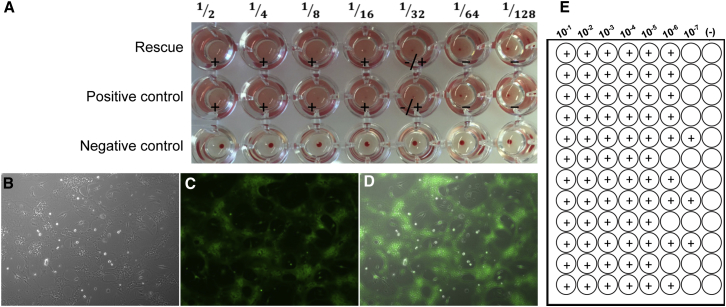
Typical Hemagglutination Assay Results Showing Successful Rescue of rNDV Expressing GFP(A) Example of a hemagglutination assay (HA). In the negative control sample (lacking virus), RBCs form a distinct pellet at the bottom of the well. In the positive control (allantoic fluid containing NDV), RBCs form a diffuse lattice-like structure. For the sample shown, RBCs begin to button at the 1/32 dilution and appear negative in the 1/64 dilution, representing an HA titer of 32. (B–D) Bright (B), fluorescent (C), and merged (D) images of DF-1 cells infected with 10 μL of allantoic fluid containing rNDV-GFP at 24 hr post-infection. Note that in DF-1 cells, rNDV causes the formation of large multinucleated cells or syncytia. (E) Example of TCID50 plate setup and scoring. In the 10−1 to 10−5 lanes all 12 replicates are positive, 10−6 has 9/12 positive wells, and 10−7 has 3/12 positive wells. Using the Spearman-Karber calculation for TCID50, the virus titer is 3.16 × 108 TCID50/mL or 2.18 × 108 PFUs/mL.